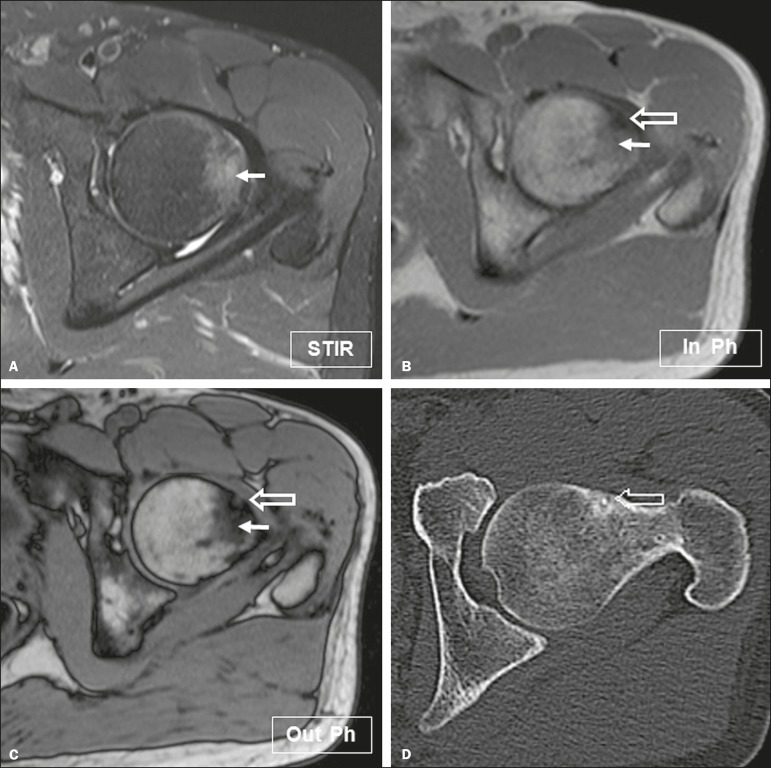
Osteoid osteoma in a 16-year-old male patient presenting with pain in the
left hip. A: Axial short inversion-time inversion recovery
MRI showing the high signal intensity of the lesion (arrow). Axial
in-phase and out-of-phase spoiled gradient-echo MRI sequences
(B and C, respectively) showing high
signal intensity of the central portion of the lesion (open arrow) on
out-of-phase image, predicting the tumor nidus. Note the low signal
intensity of the surrounding bone marrow (arrows), corresponding to
inflammatory tissue. D: Reformatted axial computed
tomographic image showing the nidus (open arrow), confirming the
diagnosis of osteoid osteoma.